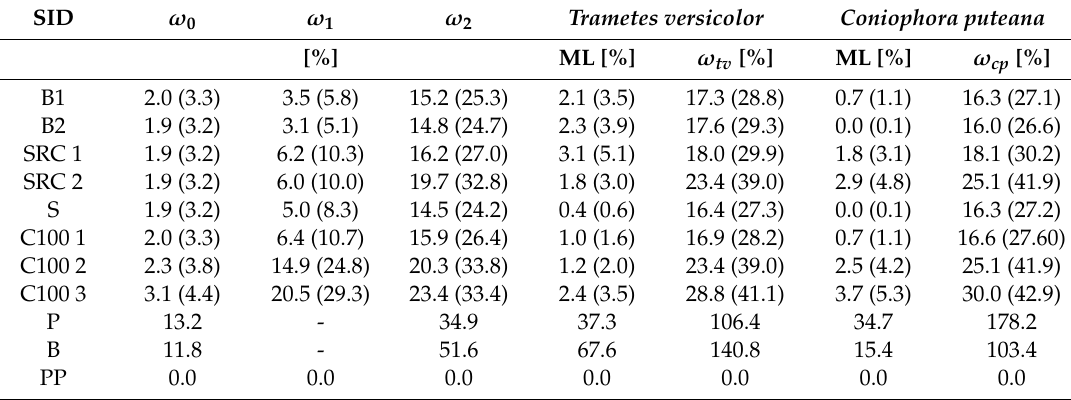
Table 2. Material moisture content ( ω ) throughout the test procedure and mass loss (ML) of the WPC. Respective wood moisture content ( ω w ) and wood mass losses (WML) are presented in parentheses.